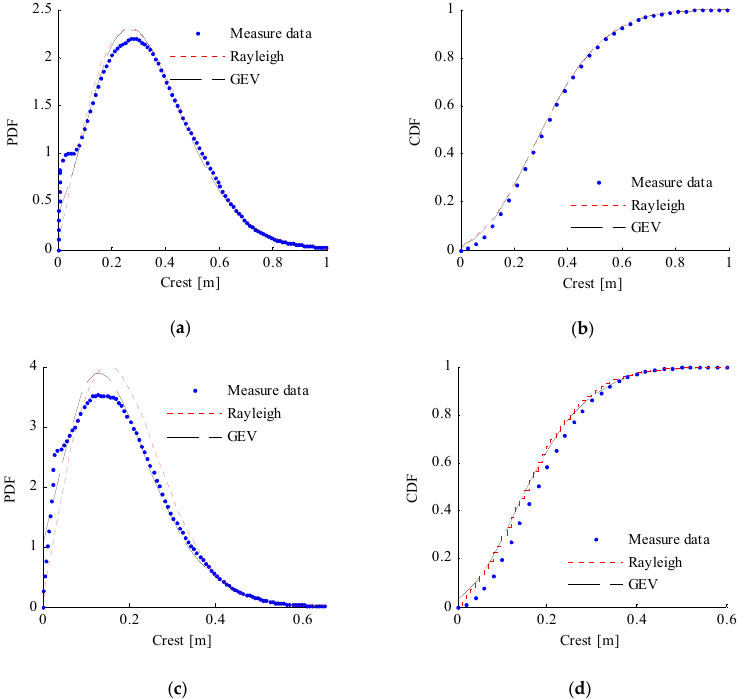
Figure 11. Computed probability density function (PDF) and cumulative distribution function (CDF) for the crest height of the measured data, and the Rayleigh and general extreme value (GEV) distributions: ( a ) crest height PDF when H s = 1.0583 m; ( b ) crest height CDF when H s = 1.0583 m; ( c ) crest height PDF when H s = 0.6069 m; and, ( d ) crest height CDF when H s = 0.6069 m.